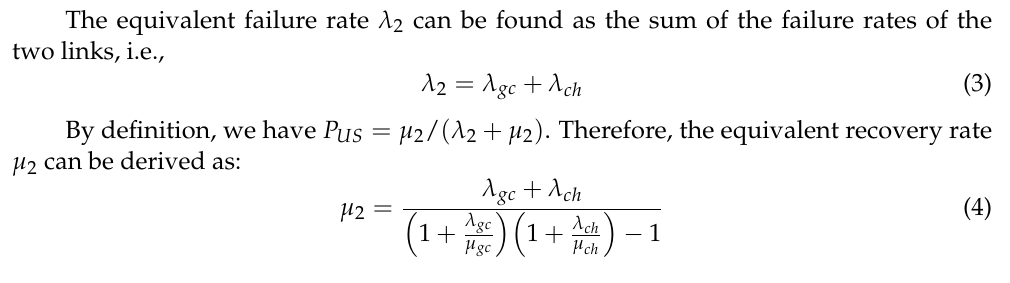
Figure 4. The series structure in Group 2.